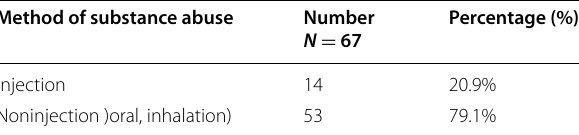
Table 6 Prevalence of injection of substance abuse among